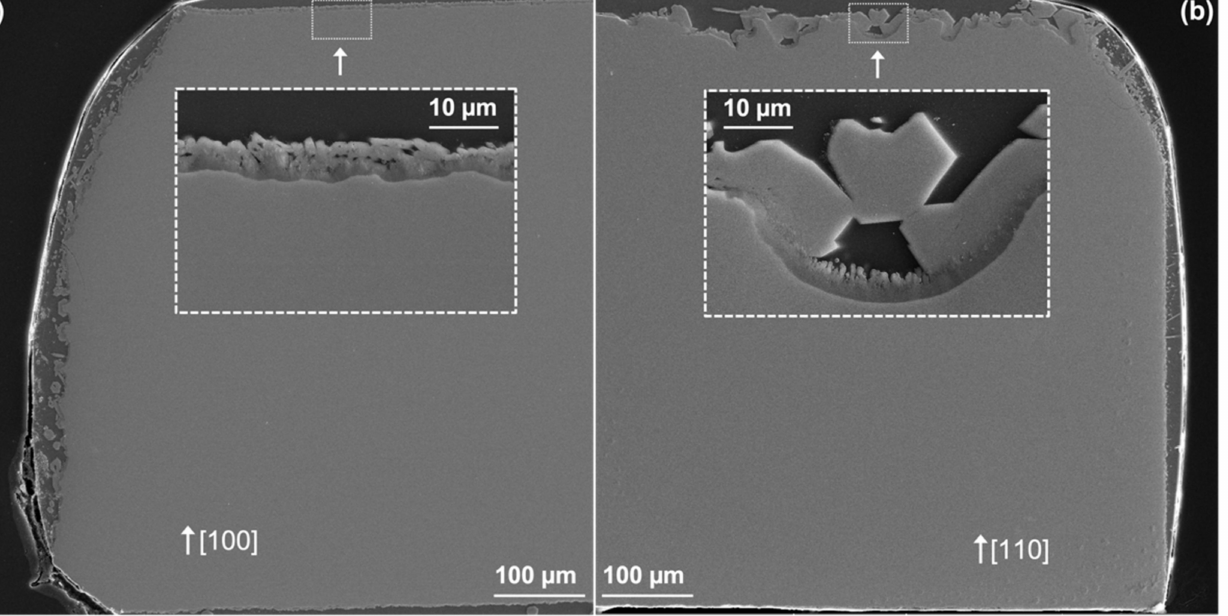
Figure 9. SE micrographs showing CMAS wetting and the edge of the reaction region after 30 min at 1350 ◦ C. The ( a ) (100) YAP substrate is representative of what is seen in the (001) YAP substrate not shown. Similarly, the (110) YAP substrate in ( b ) is representative of that seen in the (101) YAP substrate not shown. Insets show higher magnification images at the YAP/CMAS interfaces